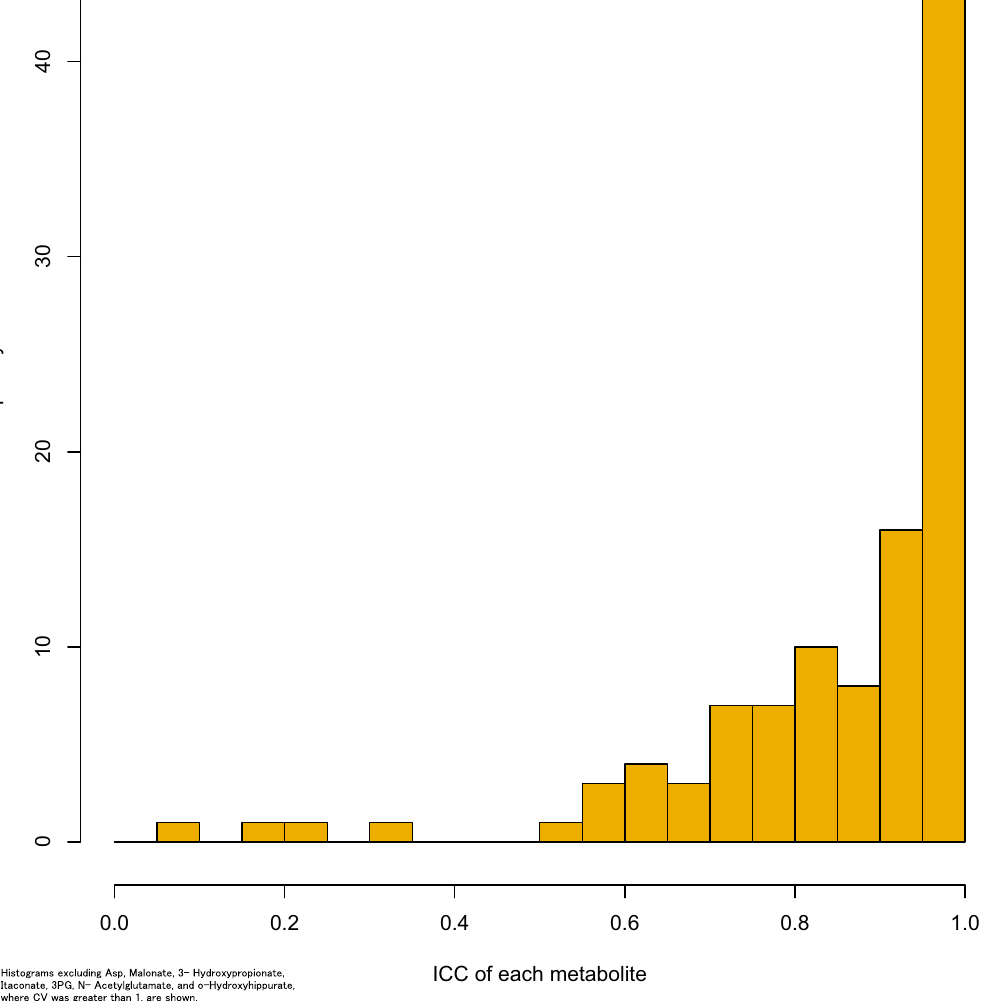
Figure 4. The distribution of the estimated ICC for each